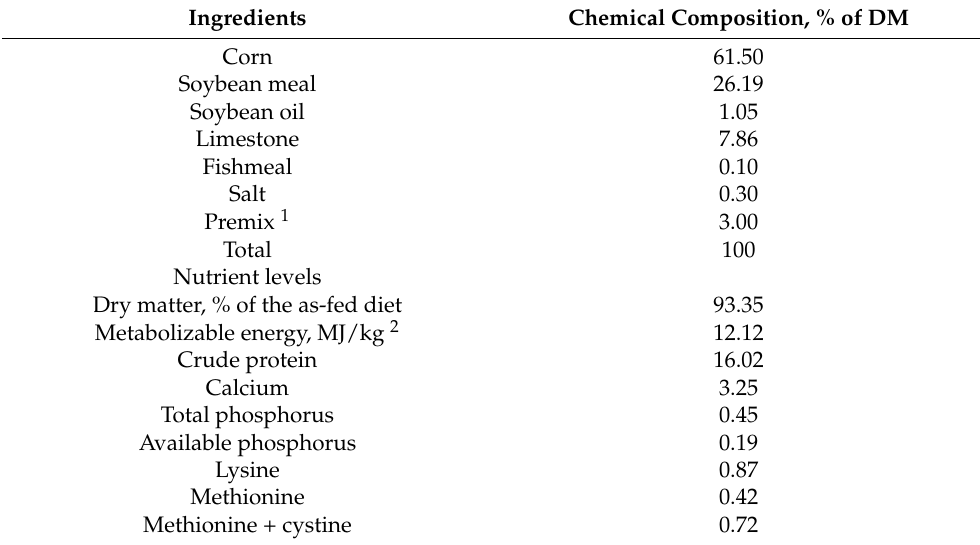
Table 1. Composition and nutrient levels of basal diets.